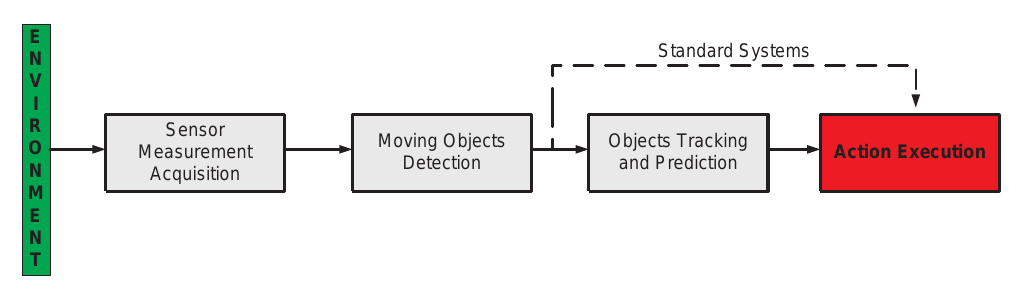
Figure 1. General system